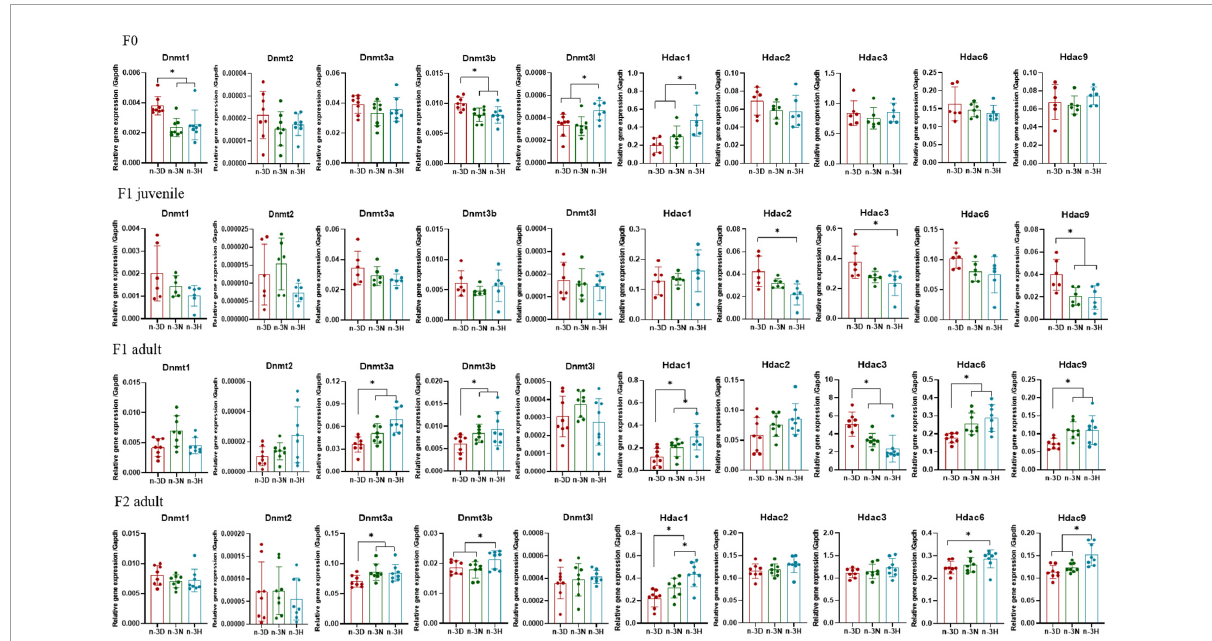
FIGURE6 Effects of paternal dietary ratio of n-6: n-3 PUFAs on the expression of Dnmts and Hdacs in the offspring testis. The protocols for production of F1 and F2 offspring as well as the experiments were the same as those described in Figure 1 . Mice from the F1 or F2 offspring were fed normal chow diet for 16 weeks. The mRNA expression of DNA methyltransferase (Dnmts) and histone deacetylases (Hdacs) in the testis was measured using real-time qPCR. n = 6–8 mice in each group. Data have been presented as mean values with standard deviation. * P < 0.05. Statistical differences were analyzed by one-way analysis of variance with Bonferroni post hoc , or Dunnett’s T3 test for data lacking homogeneity of variance. For non-normally distributed data, the Kruskal–Wallis test was used with Mann-Whitney U post hoc .